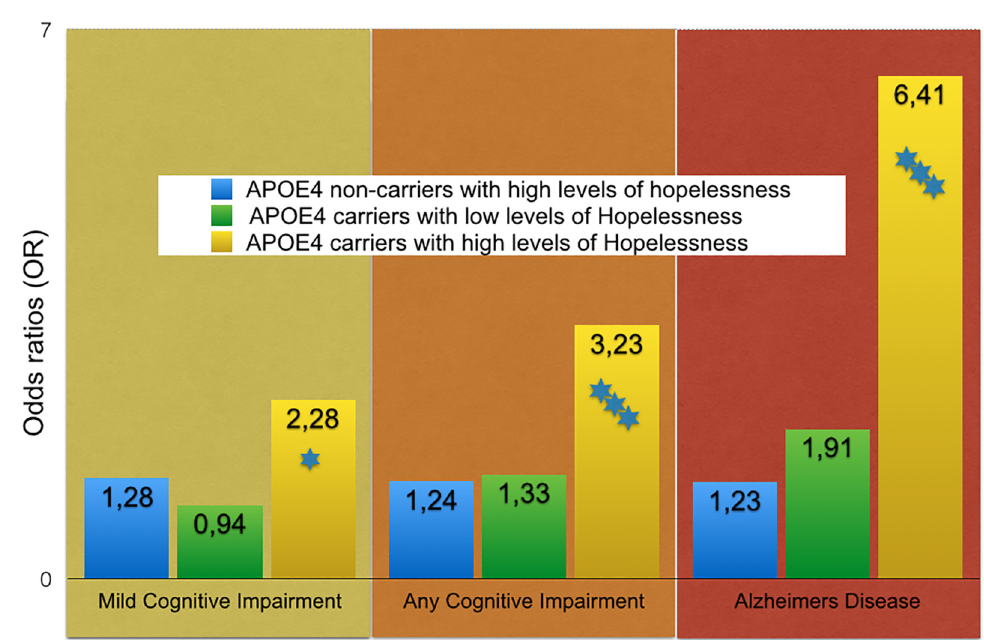
Fig 3. Hopelessness and cognitive impairment for ApoE4 carriers and non-carriers. Odds ratios from logistic regressions after adjustments for age, education, gender, BMI, blood pressure, cholesterol, residence area, occupation, physical activity, smoking, marital status, and depression. The risk is in comparison to ApoE4 non-carriers with low levels of hopelessness at midlife (OR = 1). Stars indicate the level of statistical significance (three levels < 0.05, < 0.01, <